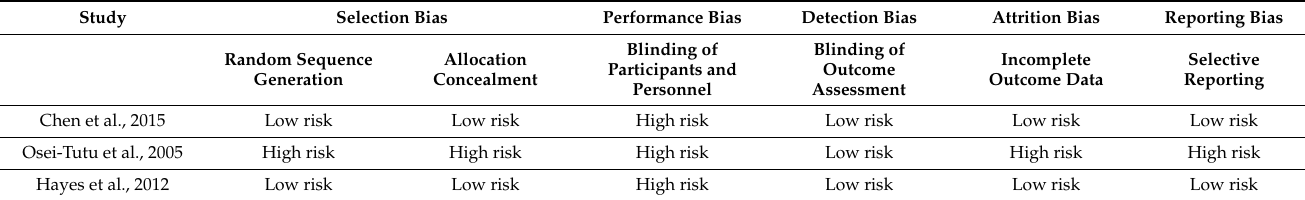
Table 2. Risk of bias of randomized controlled trials included to prevent